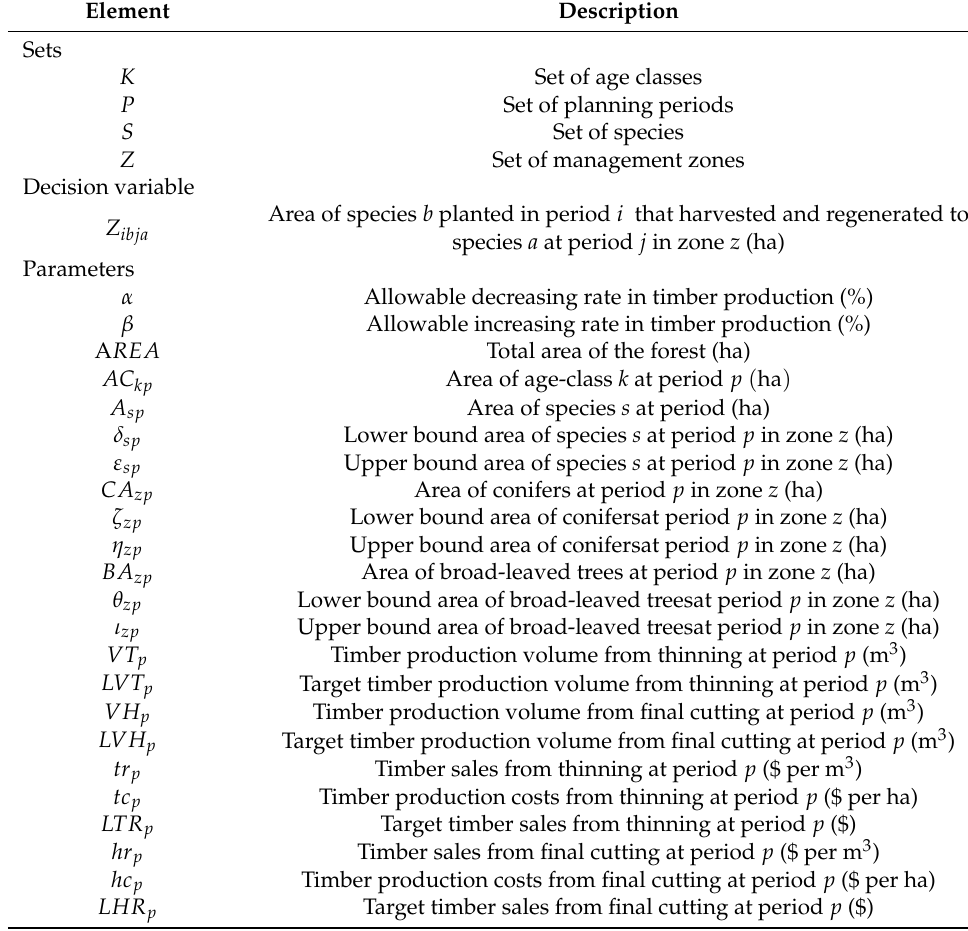
Table 3. Sets, decision variable, and parameters of the MOLP optimization